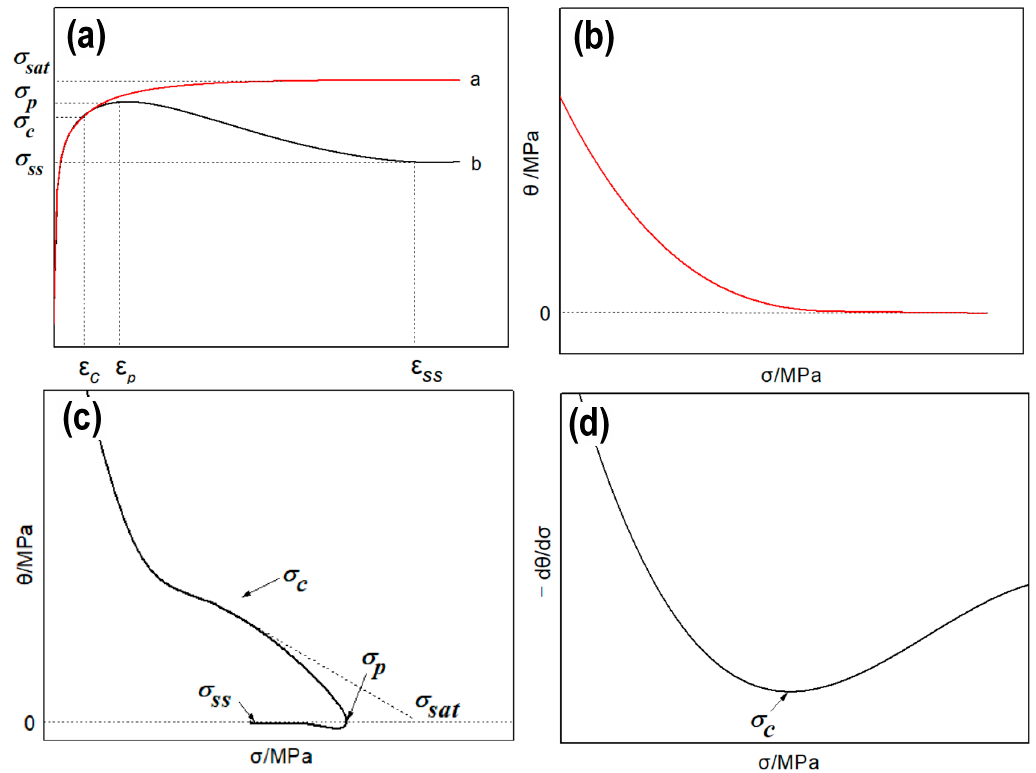
Figure 6. The relationship between strain hardening rate and flow stress. ( a ) σ - ε curve, ( b ) θ - σ curve for DRV, ( c ) θ - σ curve for DRX, ( d ) − ∂θ / ∂σ − σ curve for DRX. Table 5. The critical strain of Al–4.8Mg alloy under di ff erent hot deformation conditions. Deformation